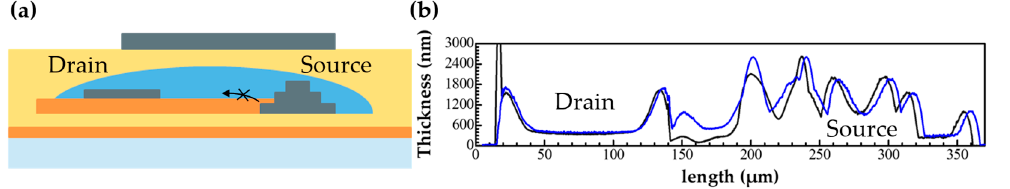
Figure 2. ( a ) Schematics of the role of blocking layer in Device III. ( b ) Cross-sectional plot between source and drain of Device III by Dektak XT. Black line: before printing semiconductor. Blue line: after printing semiconductor.